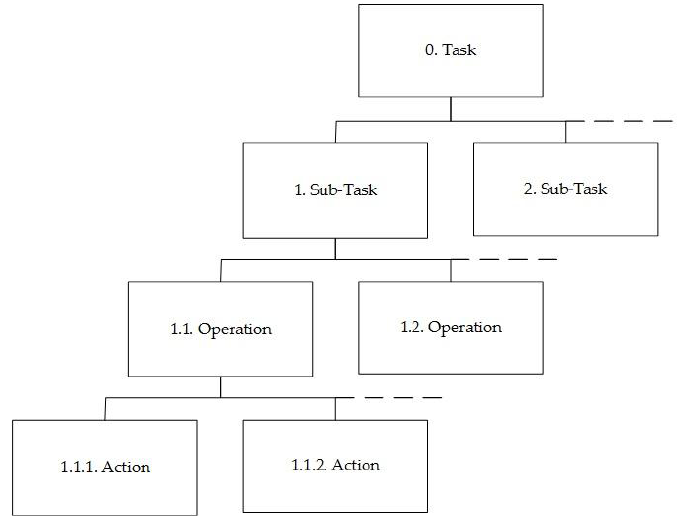
Figure 2. Structure of hierarchical task analysis.